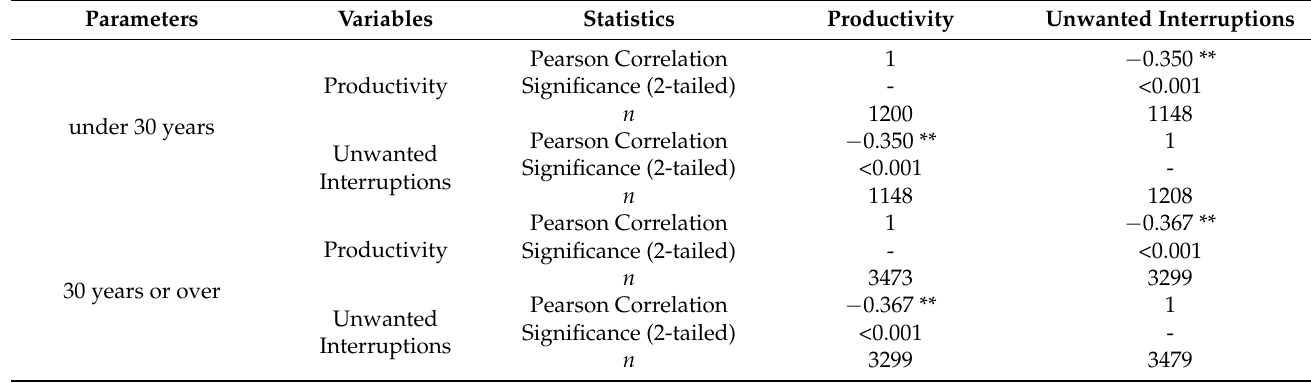
Table 12. Pearson correlation comparing productivity and unwanted interruptions for under 30 years and 30 years or over.